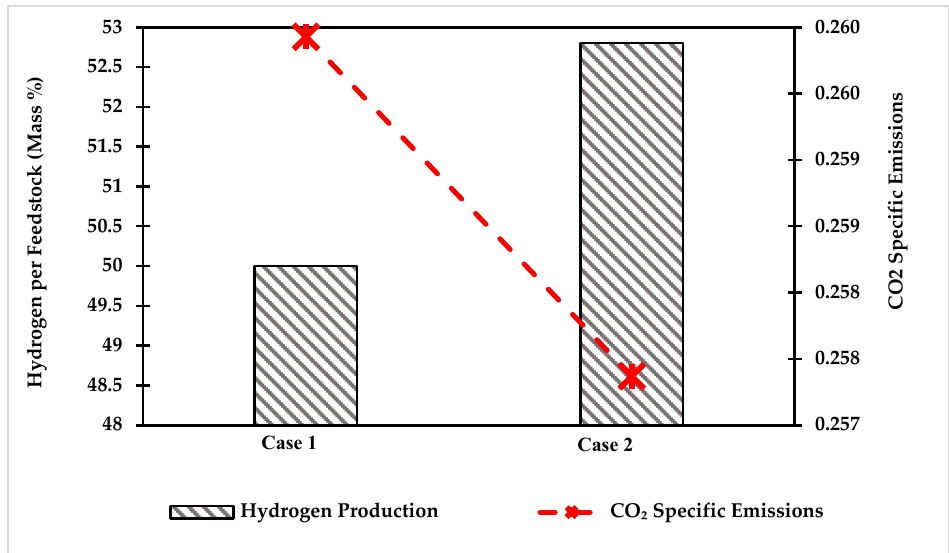
Figure 4. Comparison of hydrogen production and specific CO 2 emissions for case 1 and case 2.